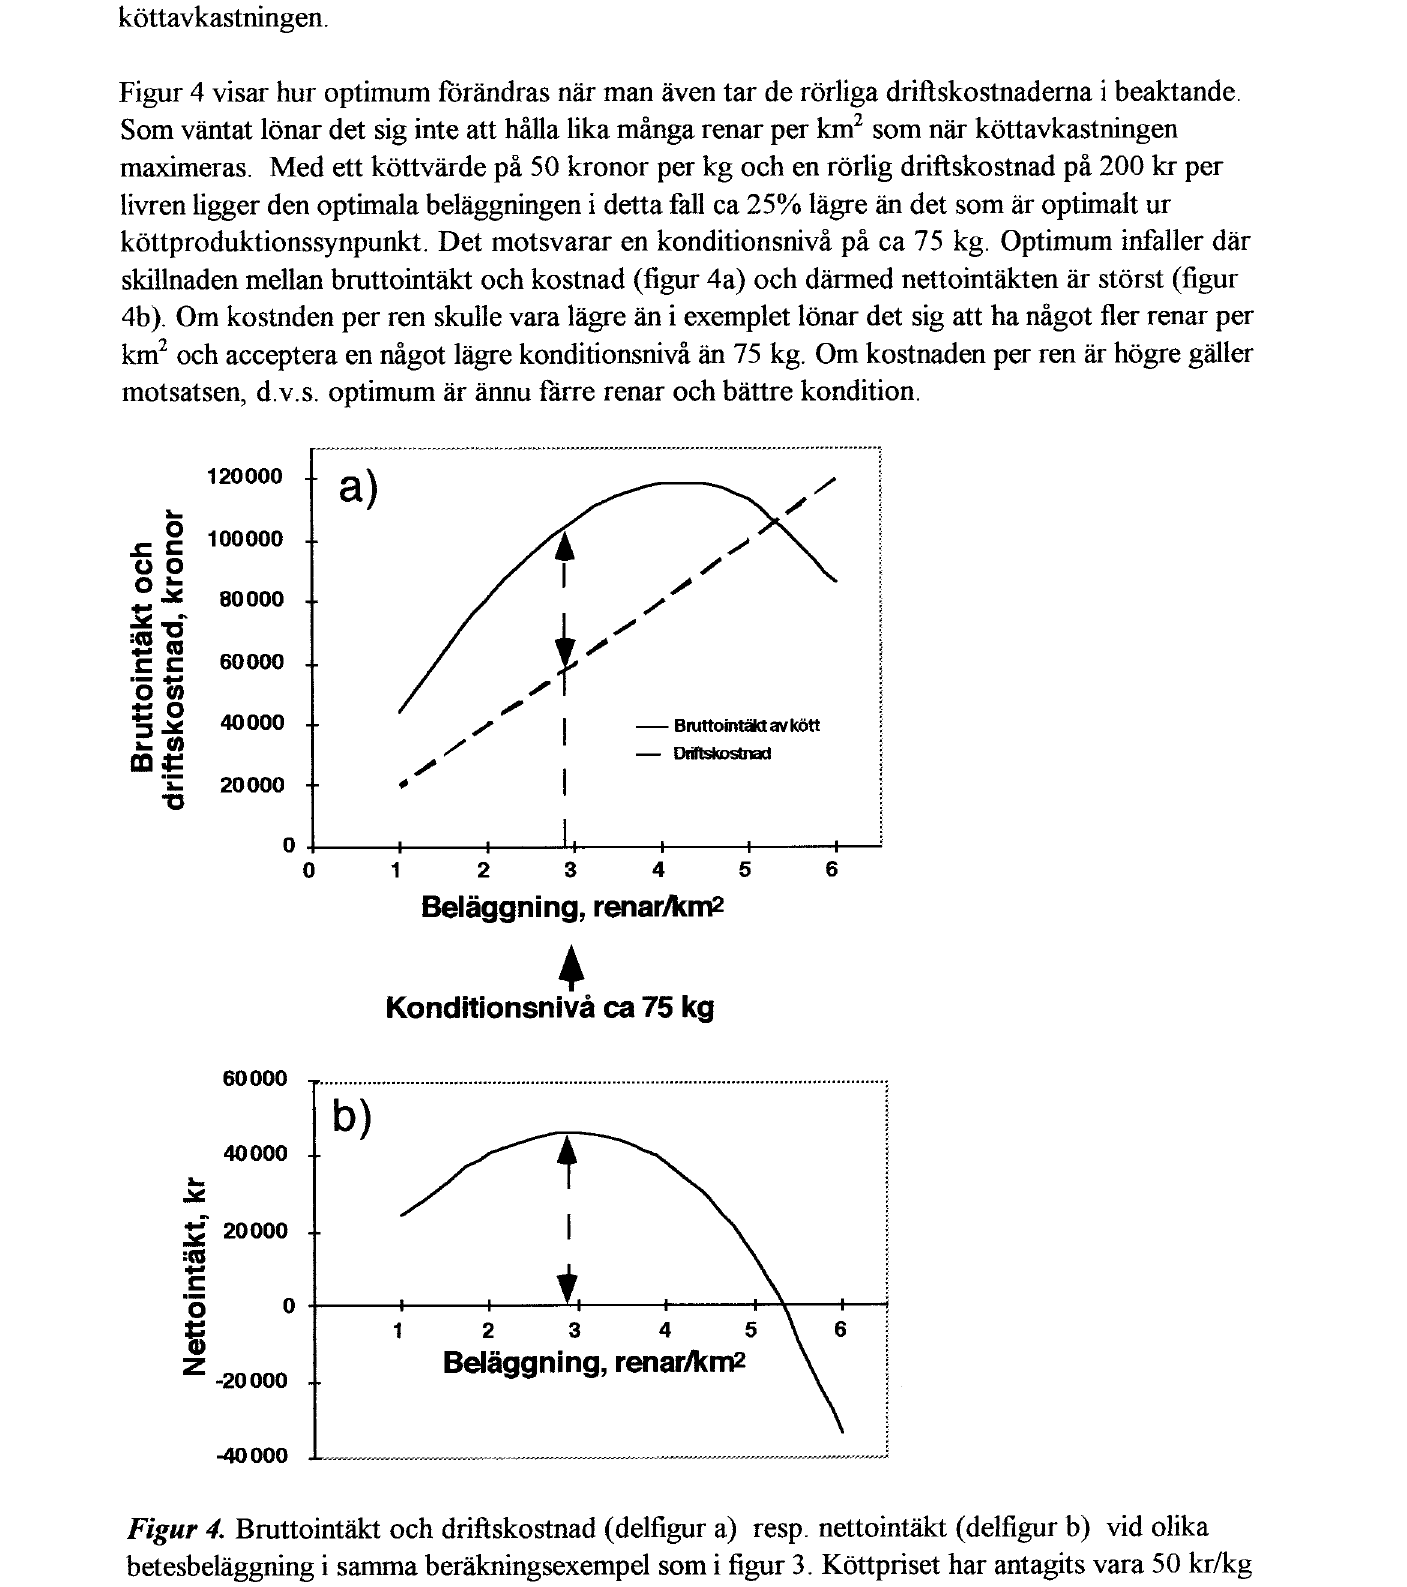
Figur 4 visar hur optimum förändras när man även tar de rörliga driftskostnaderna i beaktande. Som väntat lönar det sig inte att hålla lika många renar per km 2 som när köttavkastningen maximeras. Med ett köttvärde på 50 kronor per kg och en rörlig driftskostnad på 200 kr per livren ligger den optimala beläggningen i detta fall ca 25% lägre än det som är optimalt ur